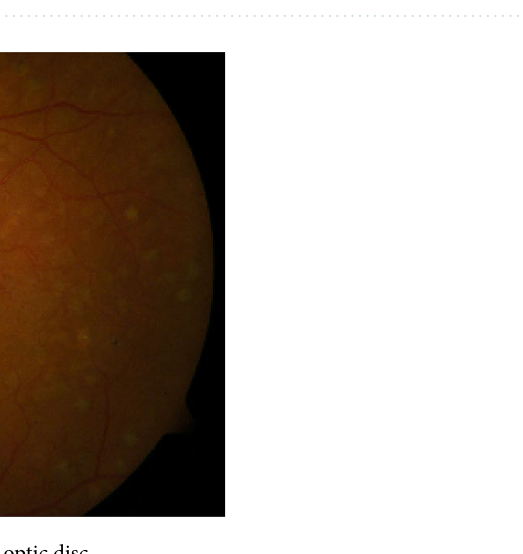
Figure 5. ( a ) A fundus retinal image, ( b ) localized red lesions by REDICA algorithm presented with blue squares and by ophthalmologist by purple squares.